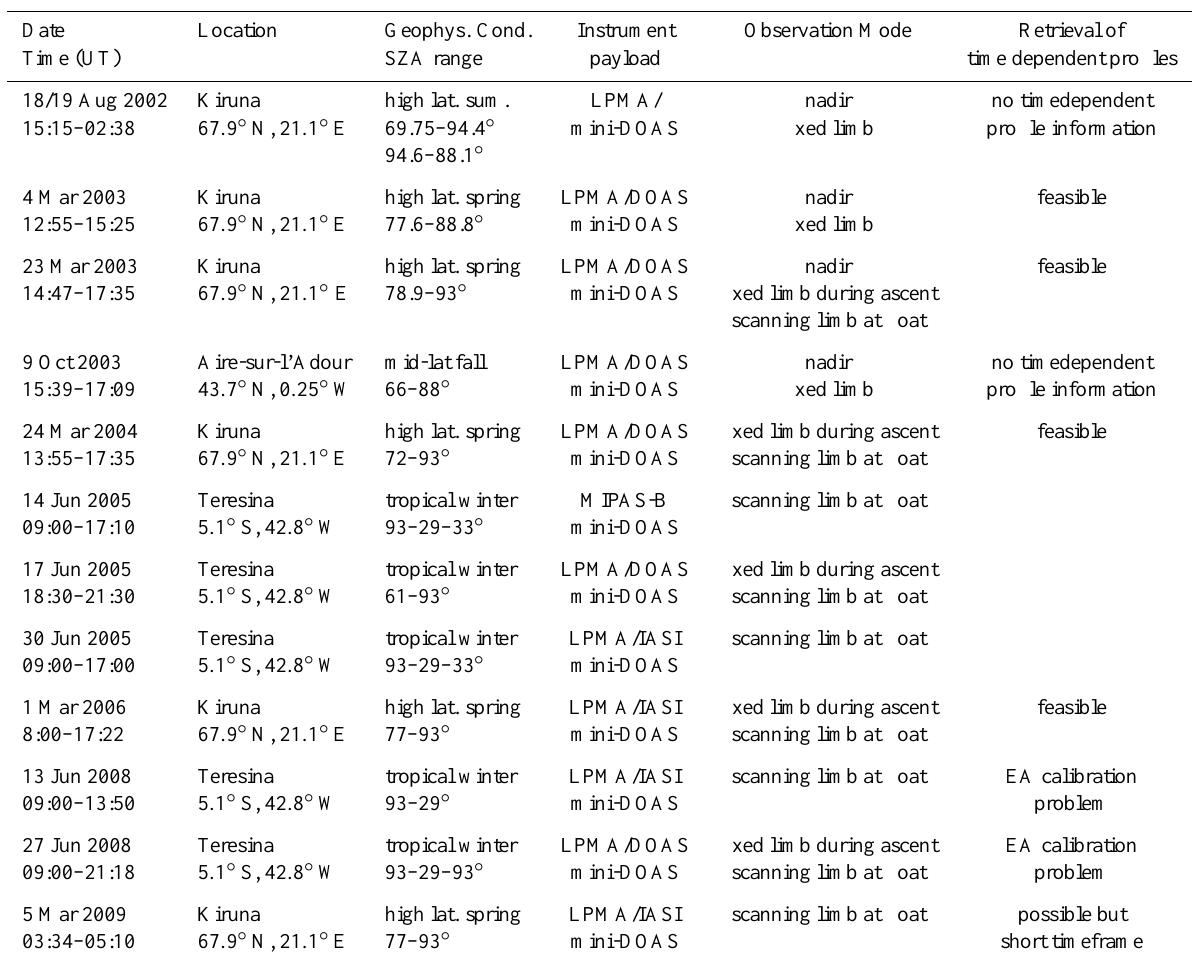
Table 1. Compendium of balloon-borne mini-DOAS